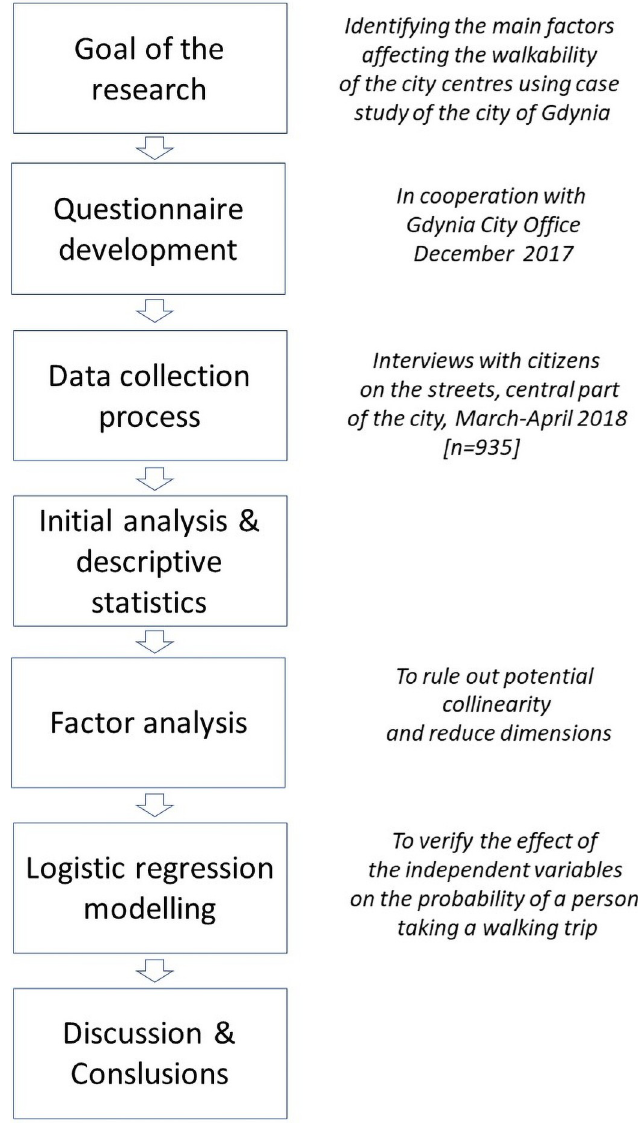
Fig 1. The research process. Source : self-study